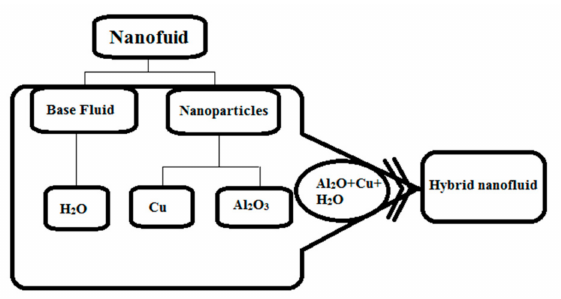
Figure 3. Preparation scheme of nanofluid and hybrid